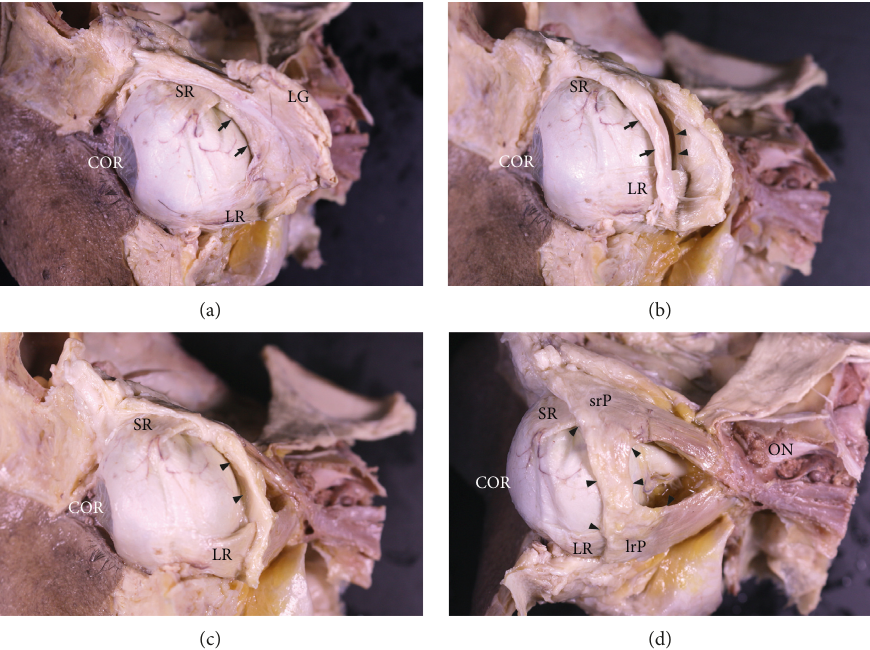
Figure 2: The anatomy of the lateral rectus muscle-superior rectus muscle (LR-SR) band and its relationship with adjacent structures. (a) The orbital part of the lacrimal gland (LG) covers the LR-SR band, and the intermuscular septum is shown anterior to the LR-SR band. (b) After excising the orbital part of the LG, the anterior border of LR-SR band is revealed. (c, d) After excising the intermuscular septum, the whole LR-SR band is revealed and connected lateral rectus and superior rectus pulleys. Arrows indicate the intermuscular septum between the LR and SR. Arrowheads indicate the LR-SR band. ON � optic nerve; srP � superior rectus pulley; irP � inferior rectus